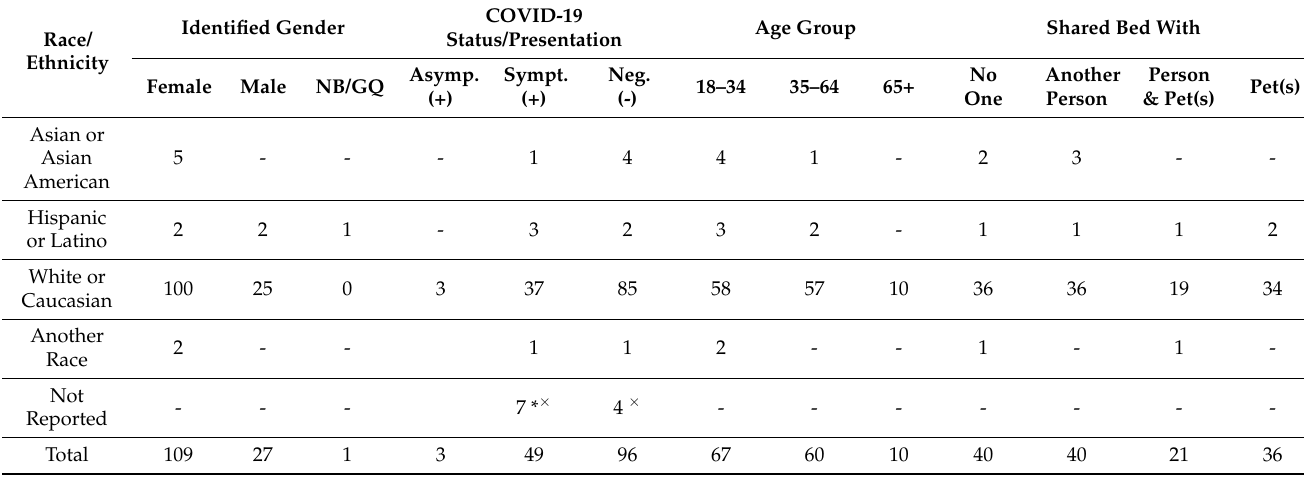
Table 4. Donor demographic data for COVID-19 T-shirt samples informing computational